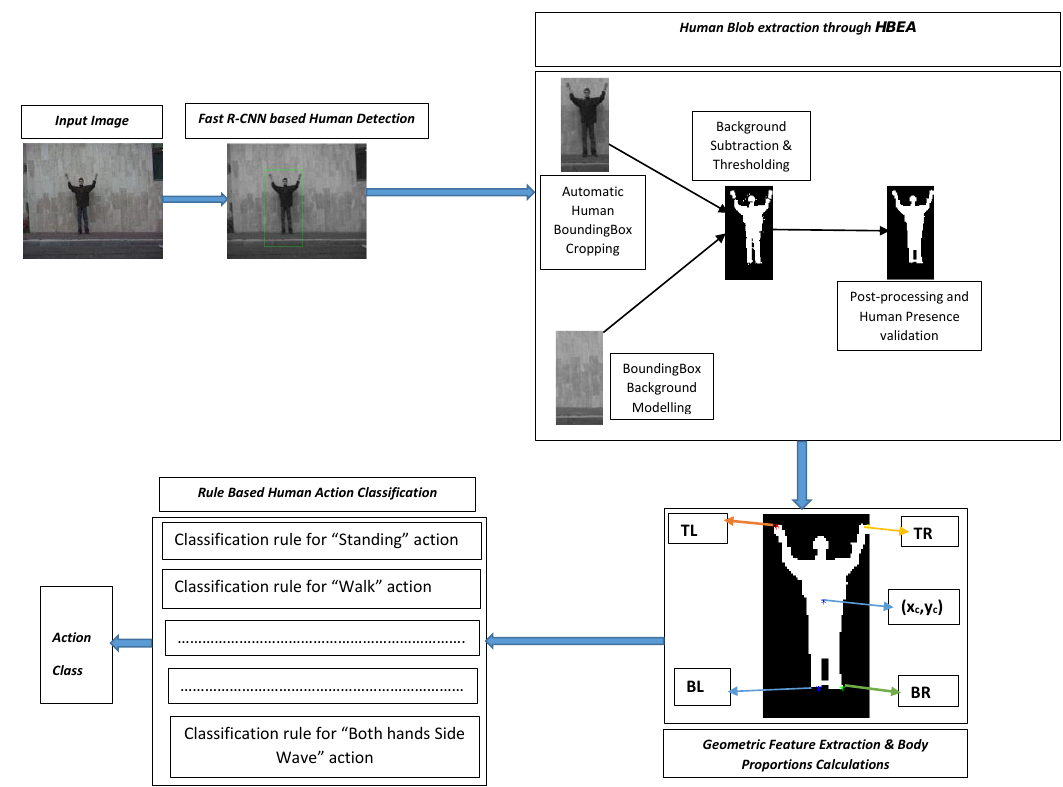
Figure 1. Workflow for the proposed